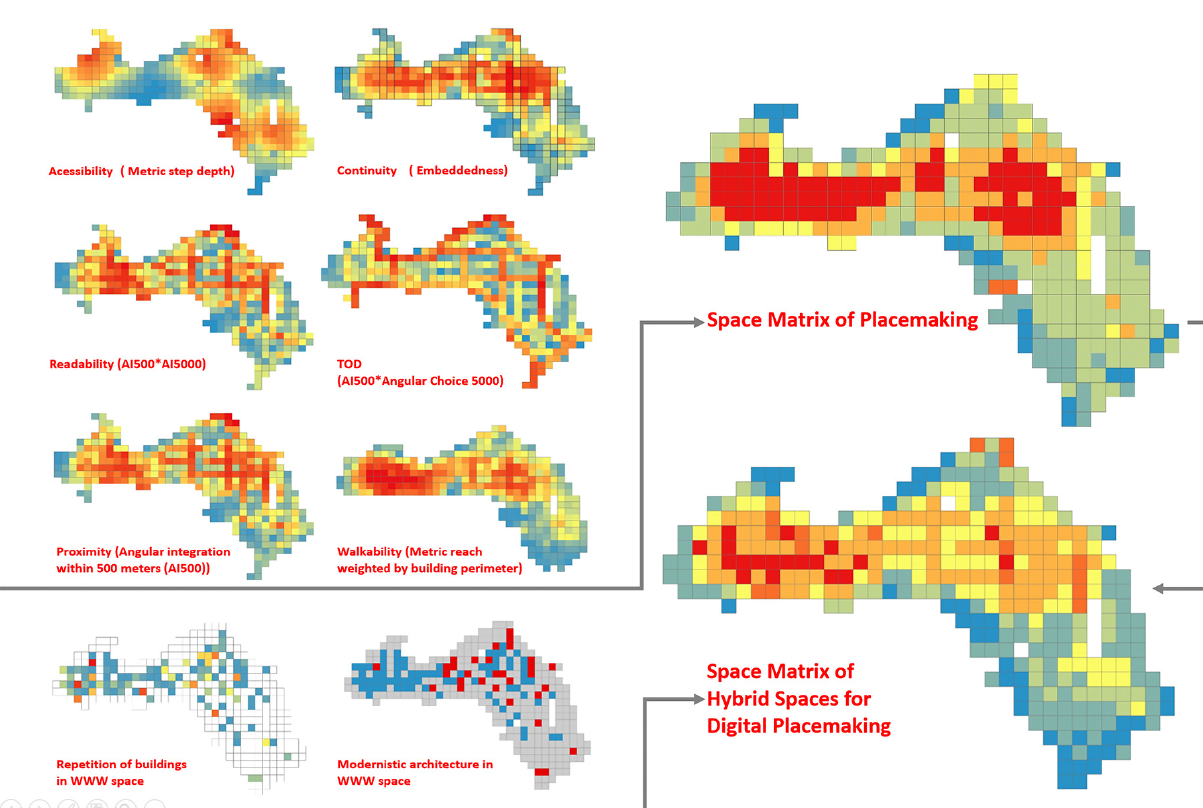
Figure 4. Construction of space matrixes for placemaking and digital placemaking. The red colour indicates the high impor‐ tance of areas for placemaking in all maps except “World Wide Web [WWW] spaces.” The red colour identifies positions of modernistic architecture